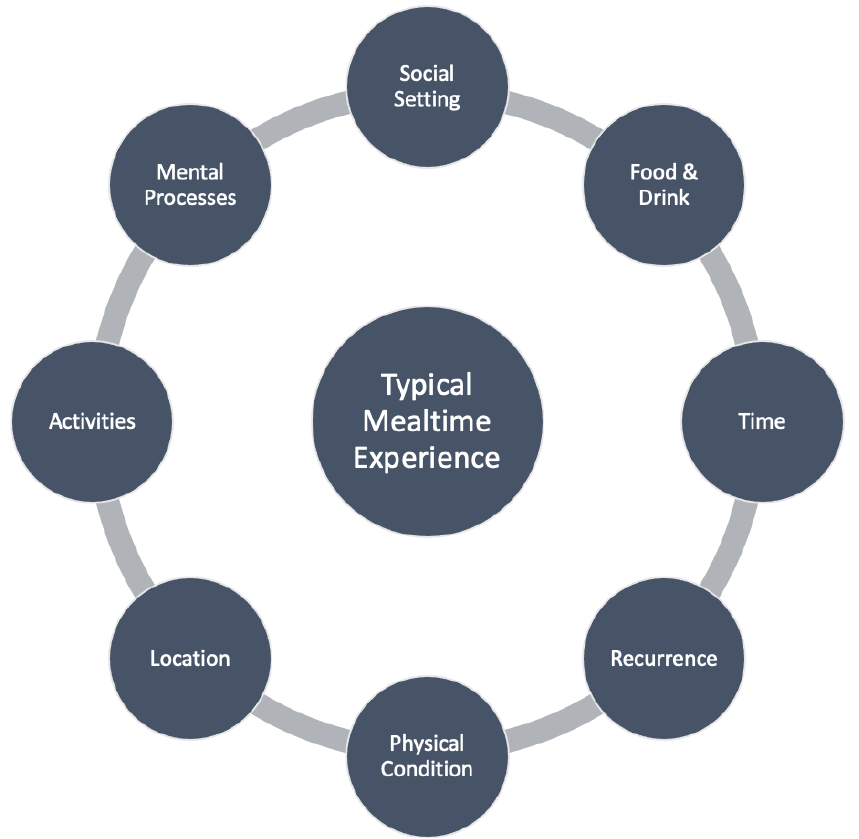
Figure 1. The eight interacting dimensions and features of eating and drinking episodes that char- acterize situational food and beverage consumption among working adults (based on [20]).